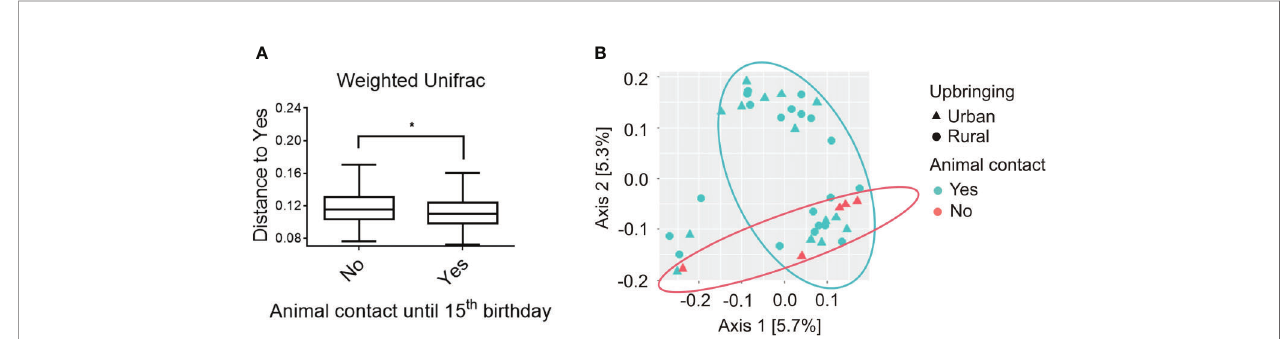
FIGURE 2 | Beta diversity analysis of salivary microbiome composition for participants with absolutely no animal contact compared to participants that were at minimum exposed to occasional animal contact until the 15 th birthday, respectively. (A) Analysis of beta diversity using weighted-UniFrac distance metrics revealed differences in the microbial community structure of participants with no animal contact at all (red, n = 5) compared to participants with at least occasional animal contact until the 15 th birthday (blue, n = 35), respectively. Distances to subjects with animal contact (Yes = animal contact; No = No animal contact) are represented by a PERMANOVA analysis with a total of 999 permutations, pseudo- F = 1.988, p = 0.038. Solid line represents the median. Lower box indicates 25th, upper box indicates 75th percentile. 10th and 90th percentile are indicated by lower and upper error bar, respectively. (B) Weighted-UniFrac principal coordinates analysis (PCoA) plot shows participants raised in rural areas in the presence of daily contact with farm animals (circles; n = 20) and participants raised in urban areas in the absence of daily animal contact (triangles; n = 20). Participants were further subdivided into the groups with “ absolutely no animal contact until the 15 th birthday ” (orange, n = 5) or “ occasional to daily animal contact until the 15 th birthday ” (turquoise, n = 35). PCoA axes 1 and 2 explain 5.7 and 5.3% of the variation, respectively. * p <